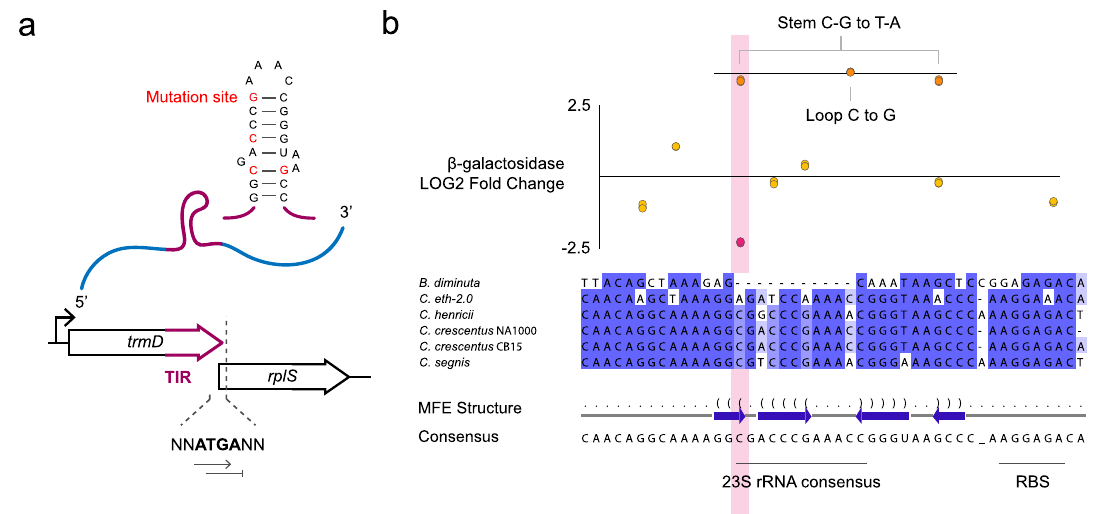
Fig. 5 Translation of rplS is regulated through a conserved secondary structure in trmD . a In silico structural analysis, the presence of Shine Dalgarno- like motifs and conservation analysis with the changes between the rewritten and native sequence as pointers converge to predict the presence of translational control elements in coupled CDS. The putative translation initiation regions of B. diminuta ATCC 11568 BDIM_RS13760, C. sp. ‘ ethensis ’ EUX21_00235, C. henricii CB4 AQ619_RS00715, C. crescentus NA1000 CCNA_00197, C. crescentus CB15 CC_0197 and C. segnis ATCC 21756 CSEG_RS1981 are depicted. b The 15 synonymous mutations, 7 of which are depicted here, introduced in the 100 bp upstream of the start codon of rplS were introduced in a translational fusion construct to lacZ on a single-nucleotide, base-by-base level. The nucleotide resolution reveals a regulatory hot spot (magenta) in the TIR of rplS . The mRNA species is predicted to contain a hairpin structure at − 13.24 kcal mol − 1 that has a higher free energy upon recoding in CETH_00197. We have uncovered a 12 bp motif within the hairpin that is also and only present in 23S rRNA. The sequence that gives rise to a secondary structure is not hardcoded — synonymous recoding to sequences that allow base pair interaction or that are present in the loop is allowed (orange). Data are presented as one dot per independent measurement. Dots per sample amount to a total of n = 3. Dots corresponding to measured values for the stem C-G to T-A mutation are depicted at both mutations sites and amount to a total of n = 3. Source data are provided as a Source Data fi